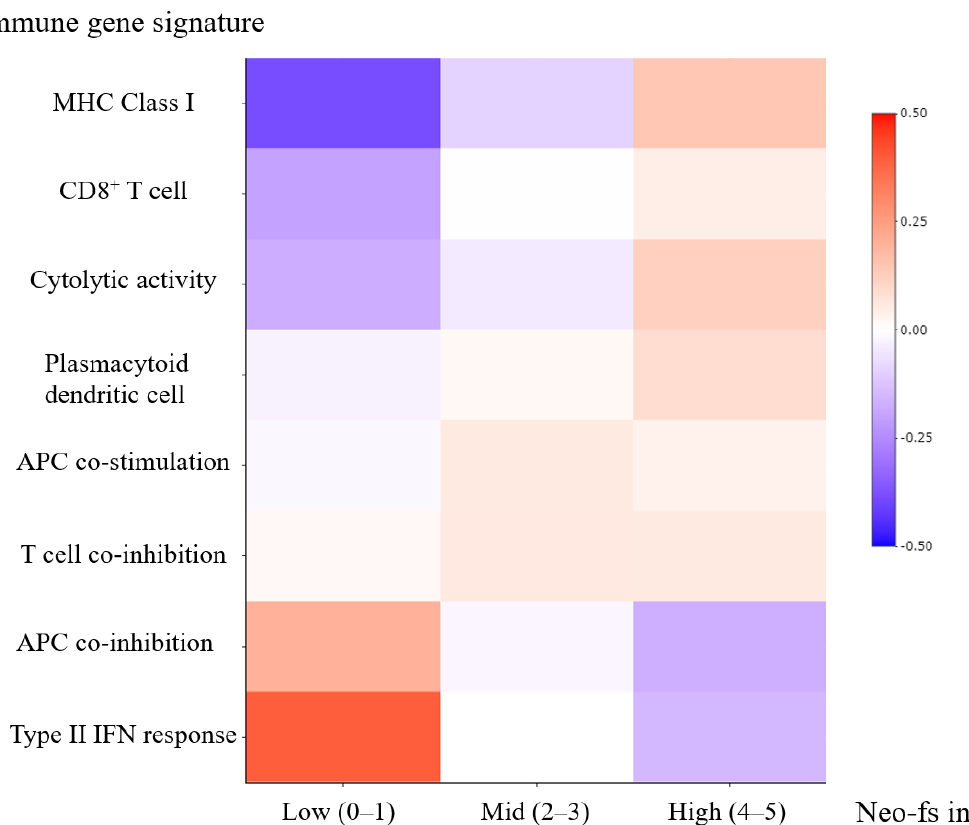
Figure 2. Heatmap depicting immune gene signatures according to RNA seq-based Neo-fs index in clear cell renal cell carcinoma. Immune gene signatures (mean z-scores) according to low- (0–1), mid- (2–3), and high (4–5) Neo-fs index were illustrated as a heatmap. Clear cell renal cell carcinoma samples with high Neo-fs index were enriched for genes associated with MHC Class I, CD8+ T cells, cytolytic activity, and plasmacytoid dendritic cell immune signatures. They were slightly enriched for immune gene signatures for APC co-stimulation and T cell co-inhibition. In contrast, they harbored decreased gene expressions associated with APC co-inhibition and type II-IFN response.